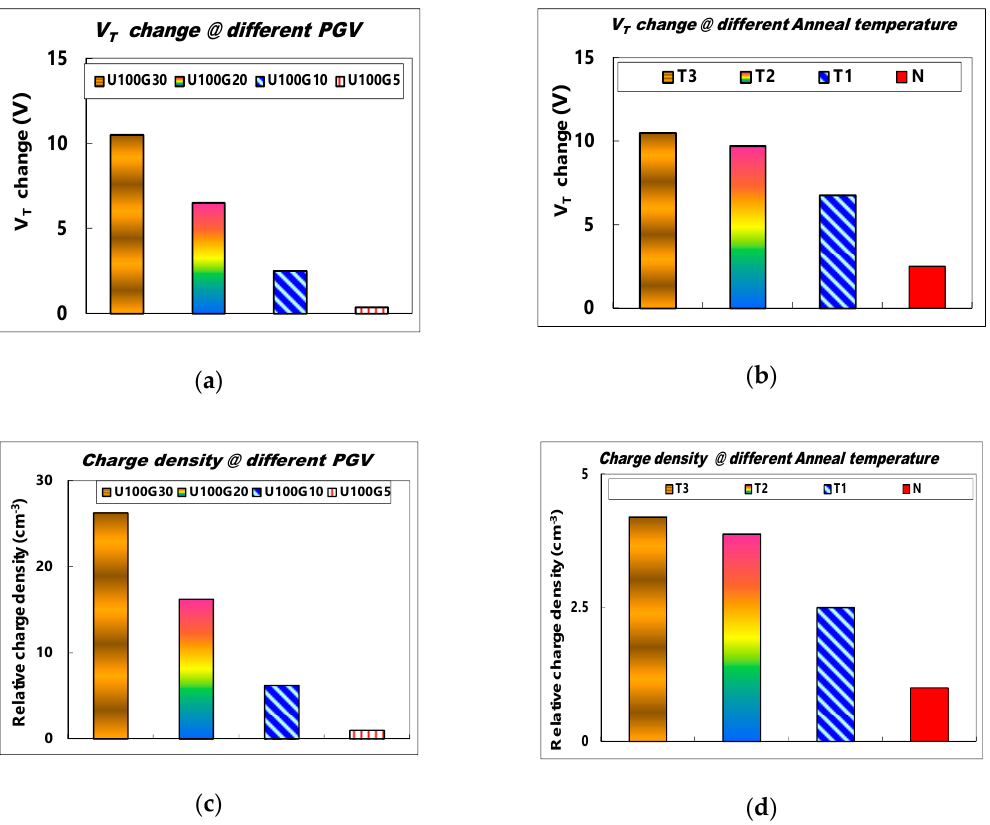
Figure 5. ( a ) The UV-induced V T change comparison of SAHAOS-T3 capacitor devices at different PGVs after 100 mW · s/cm 2 UV TD irradiation; ( b ) the UV-induced V T change comparison for various SAHAOS and SONOS capacitor devices with different PMA temperatures after the U100G30 irradiation condition; ( c ) the relative UV-induced charge density comparison of SAHAOS-T3 capacitor devices at different PGVs after 100 mW · s/cm 2 UV TD irradiation; ( d ) the relative UV-induced charge density comparison for various SAHAOS and SONOS capacitor devices with different PMA temperatures after the U100G30 irradiation condition.